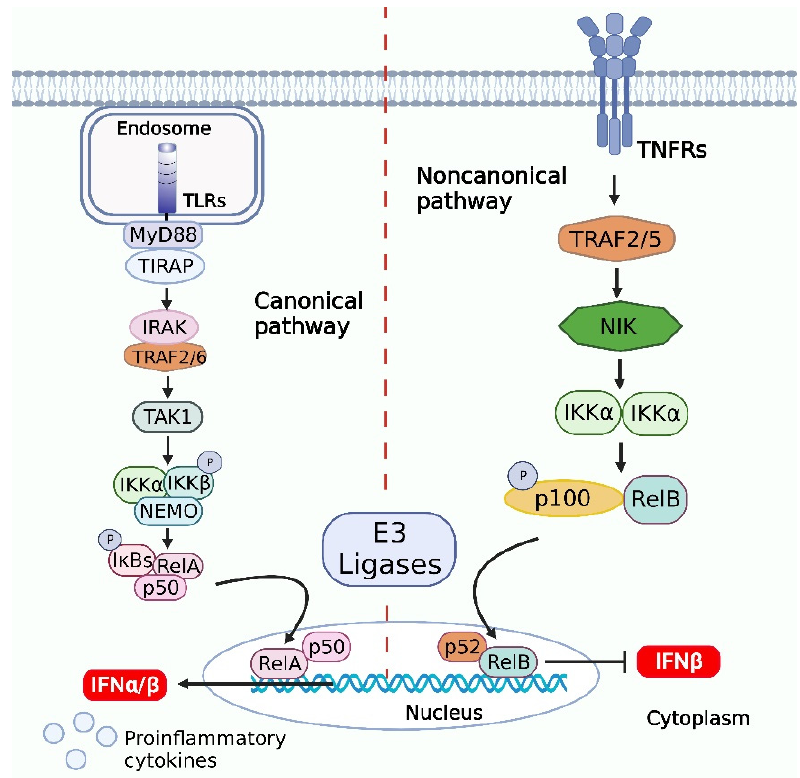
Figure 3. Activation of NF- κ B signaling pathways and downstream signaling pathways in response to viral infections. Canonical pathway, the signal transduction via myeloid differentiation factor 88 (MyD88) requires the interaction of toll-interleukin-1 receptor (TIR) homodimers and IL-1 receptor-associated kinase (IRAK), which phosphorylates MyD88 and recruits and activates tumor necrosis factor (TNF) receptor-associated factor (TRAF)6, followed by the activation of transforming growth factor β -activated kinase (TAK)1. The activated TAK1 induces the formation of the inhibitor of NF- κ B kinase trimer (IKK) trimeric complex, and the IKK complex is activated and promotes the phosphorylation of I κ B α , which is subsequently ubiquitinated and degraded in the presence of E3 ligase. Upon degradation, I κ B α releases p50/RelA into the nucleus, which binds to the promoters of specific genes, initiating the transcription and expression of the genes. The noncanonical pathway is dependent on IKK α but not NF- κ B essential modulator (NEMO), and when a cell receptor binds to the corresponding ligand, it recruits and activates the adaptor NF- κ B-inducing kinase (NIK), which activates IKK α . Subsequently, the activated IKK α binds to p100 or p105, which is ubiquitinated and degraded by E3 ligase. p100 is degraded to generate p52, which can form a p52-RelB heterodimer or a p52-p52 homodimer. The p52/RelB heterodimer can enter the nucleus directly and bind to the promoter of a specific gene to initiate gene transcription. In addition, it is likely that the virus-induced NIK upregulation and noncanonical NF- κ B activation inhibit the type I IFN induction. The